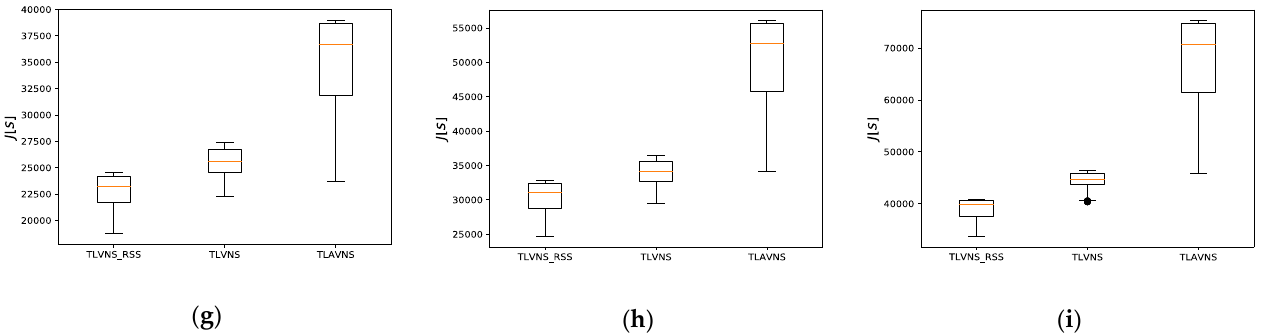
Figure 8. ( a – c ) The distribution of solutions for the small sized problem; ( d – f ) The distribution of solutions for the medium sized problem; ( g – i ) The distribution of solutions for the large sized problem.